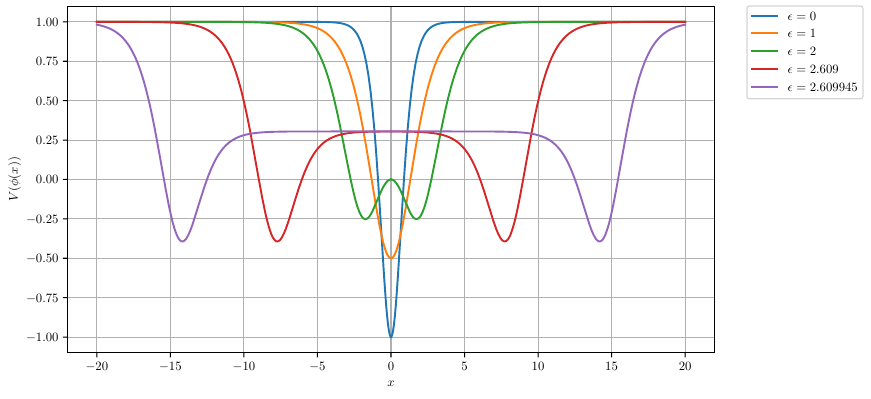
Figure 3 . The mass M ( (cid:15) ) of a static kink as a function of the deformation parameter (cid:15) .